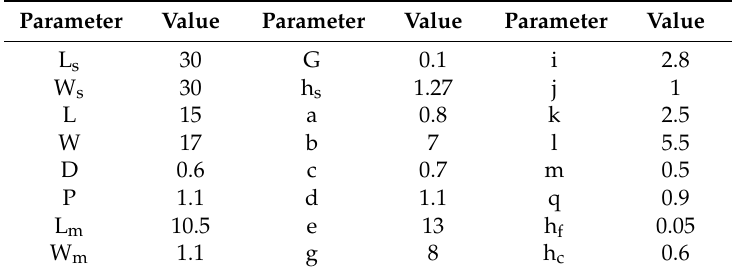
Table 1. Design parameters for the TM 20 -mode QMSIW resonator (unit: mm).